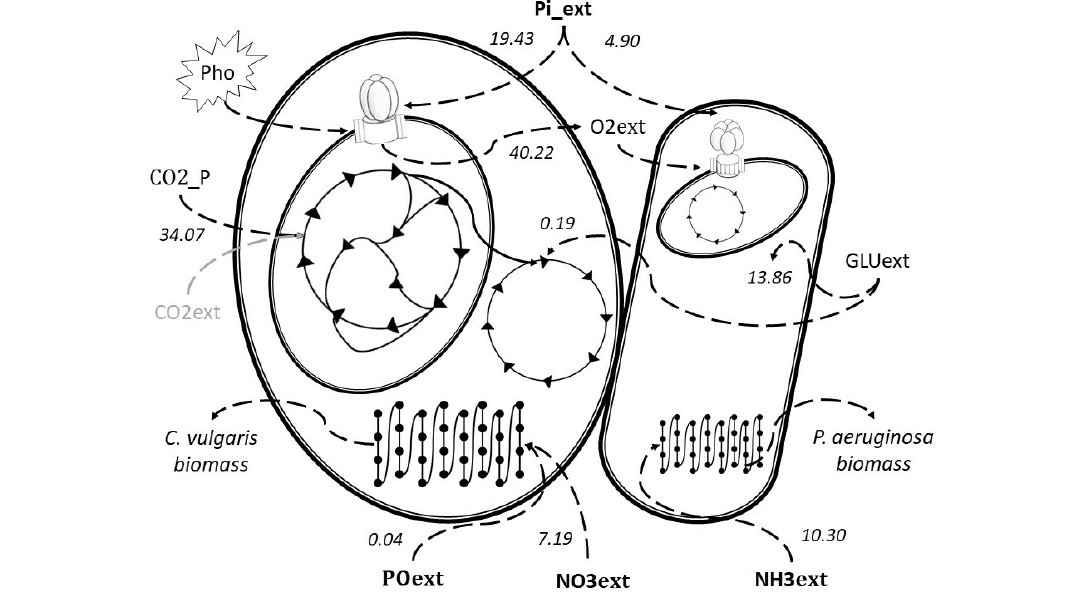
Figure 3. Schematic representation of ExPA with the highest yield of nutrient uptake under photoheterotrophic condition for the consortium of C. vulgaris and P. aeruginosa . The numbers represent yields of uptaking or producing indicated compounds; the units are mmol of nutrient per g DW of microorganism, respectively; dotted and solid lines represent the exchange and the internal fluxes for each